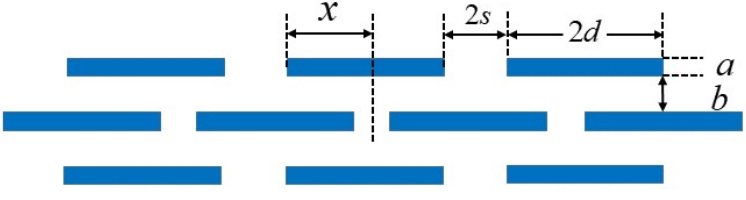
Figure 7. Ribbon arrangement of platelets.